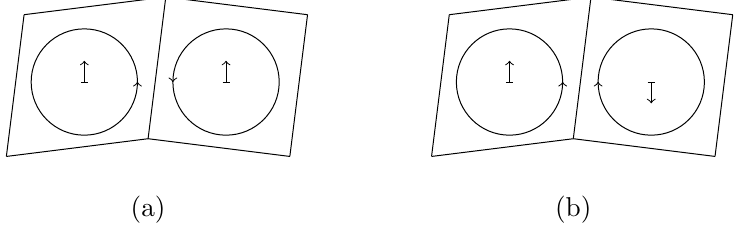
Figure 12 . A cross section image of two possibilities for the orientation of faces that meet at a common edge in M . In (a) the two faces will induce opposite orientation on the common edge E , while in (b) the two faces will induce the same orientation on the common edge E